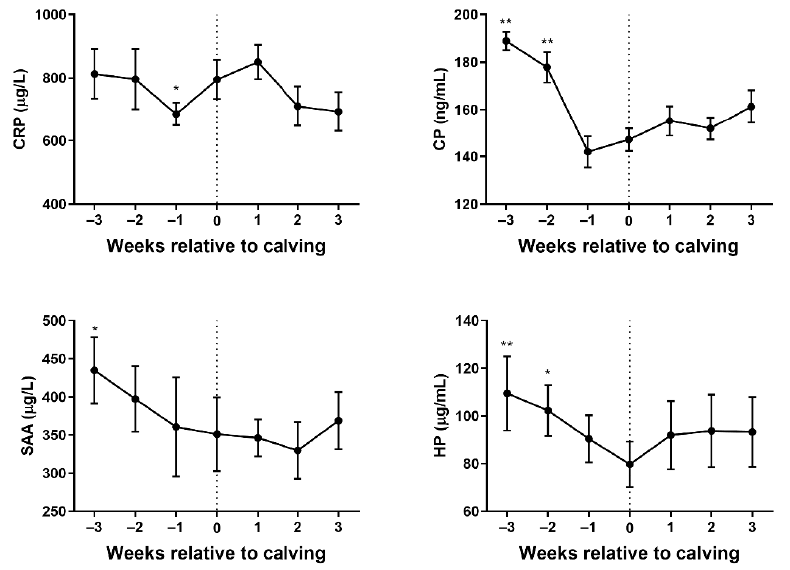
Figure 2. Changes in plasma concentrations of C-reactive protein (CRP), ceruloplasmin (CP), serum amyloid A (SAA), and haptoglobin (HP) in dairy goats at ± 3 weeks delivery. Statistical significance was indicated at * p < 0.05 and ** p < 0.01 in comparison with the delivery day.